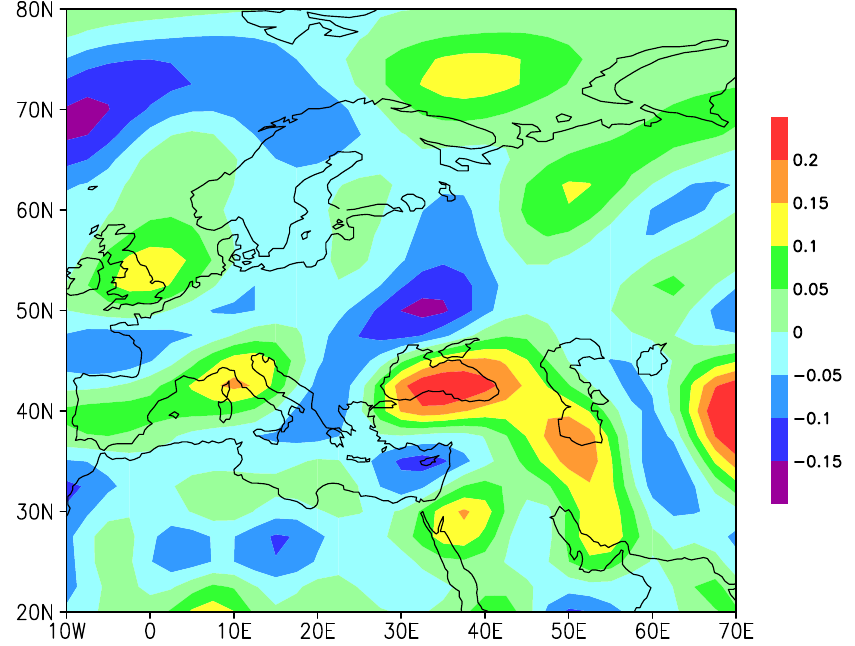
Figure 9. Omega map (Pa·s − 1 ) at 1000-hPa for 24 March 00:00 UTC. Red-to-yellow area corresponds to a sink area, while negative values show upward movement of air.